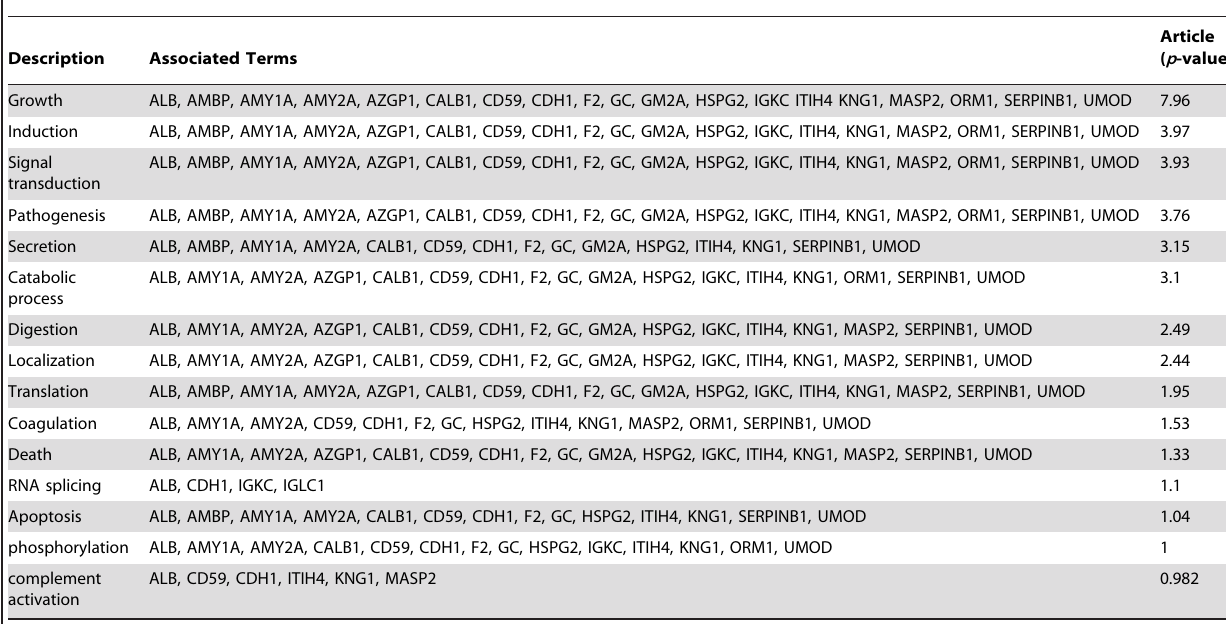
Table 3. Top 15 of total 1600 bio-process for the twenty identified proteins in Pubgene.